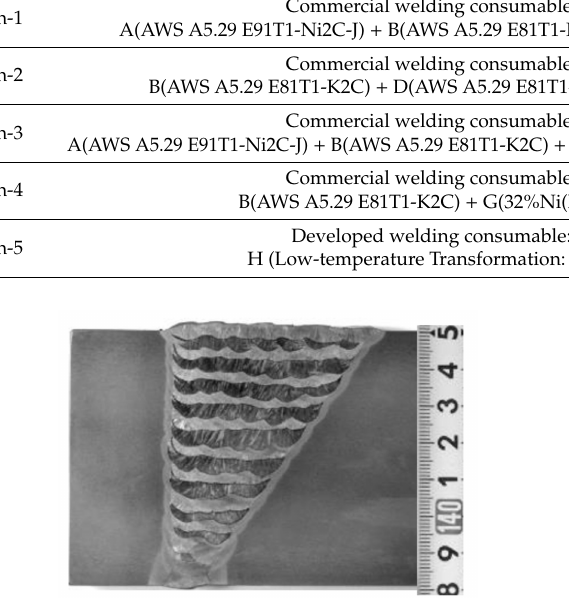
Figure 4. Special welding zone details of specimens 1, 2, 3, 4, and 5. Table3. Informationofweldingconsumablesusedinthespecialweldingparttopreventbrittlefractures. Items